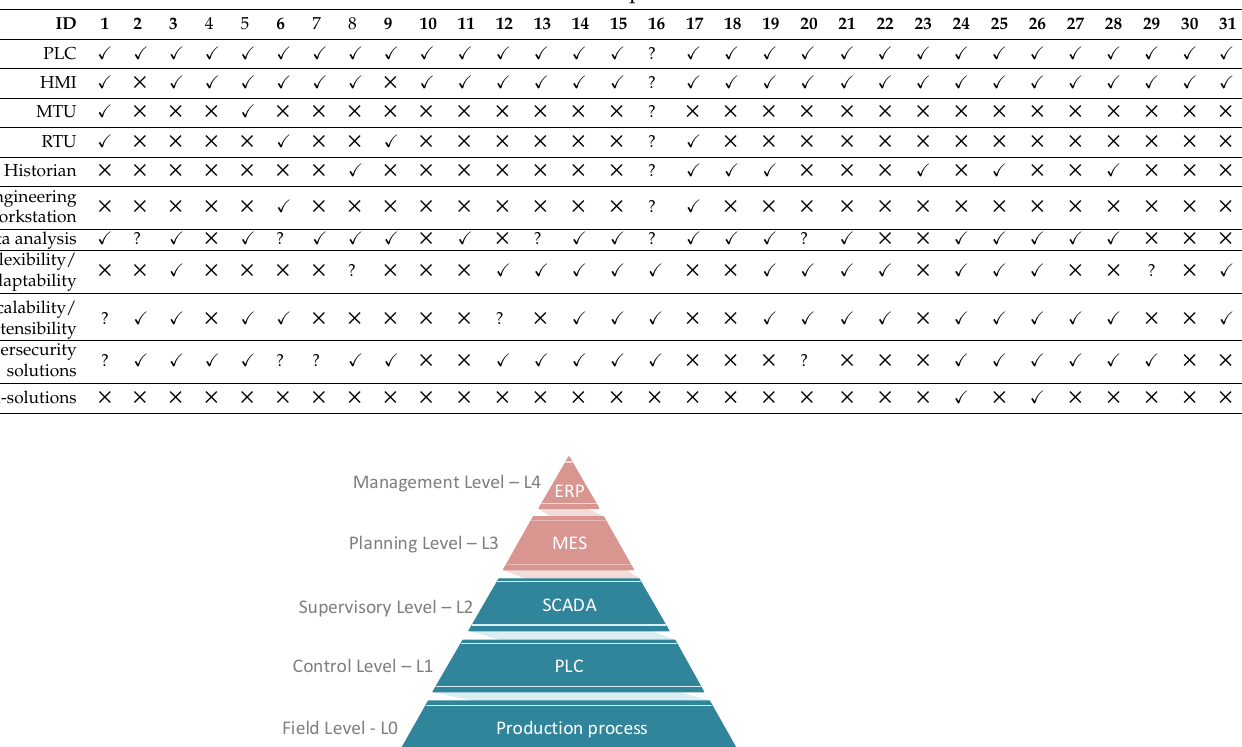
Table 2. Testbeds’ parameters.